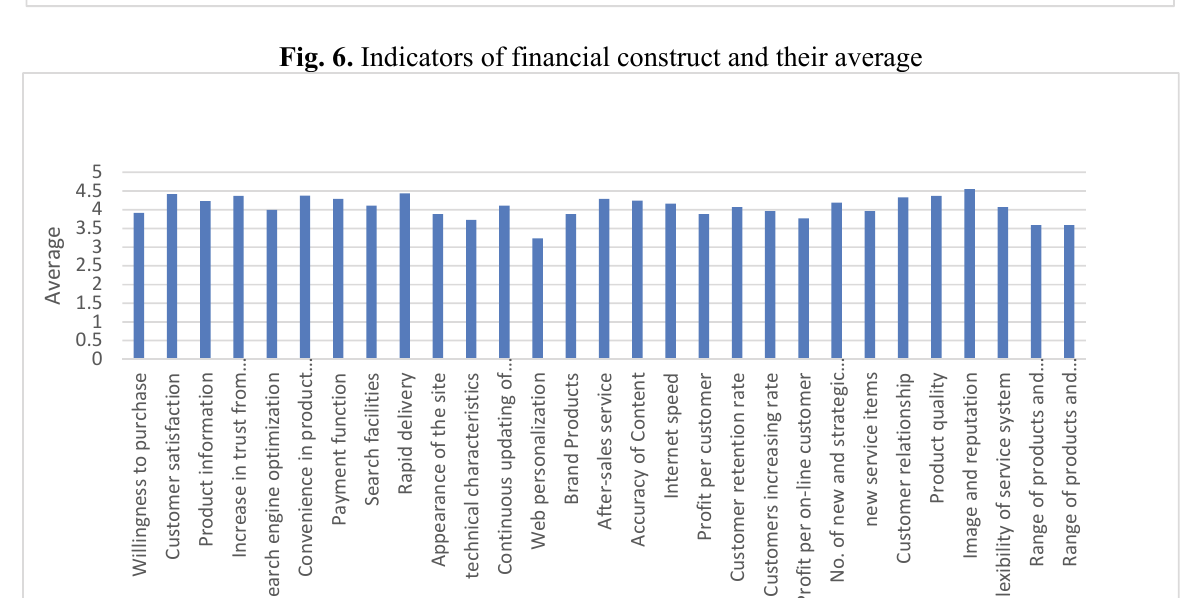
Fig. 7. Indicators of customer construct and their